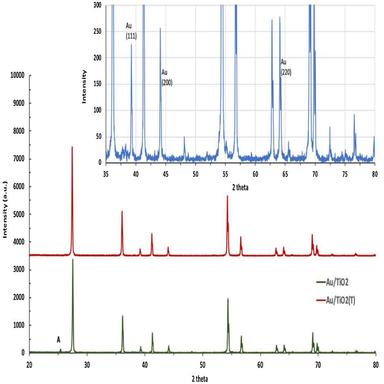
X-ray diffraction pattern of nanocomposite Au0 (NPs)/TiO2 and Au0 (NPs)/TiO2(T) materials annealed at 800 C.